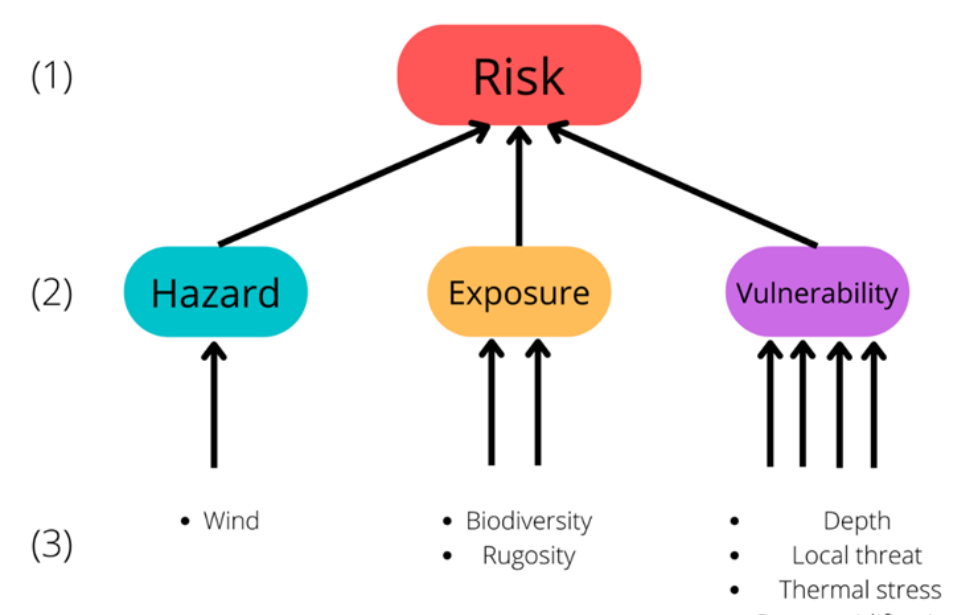
Figure 2. Risk index flowchart from indicator level (3) to index (2) and risk (1) levels. Each indicator is listed in level 3 grouped depending on the categorisation under either hazard, exposure, or vulnerability indices.